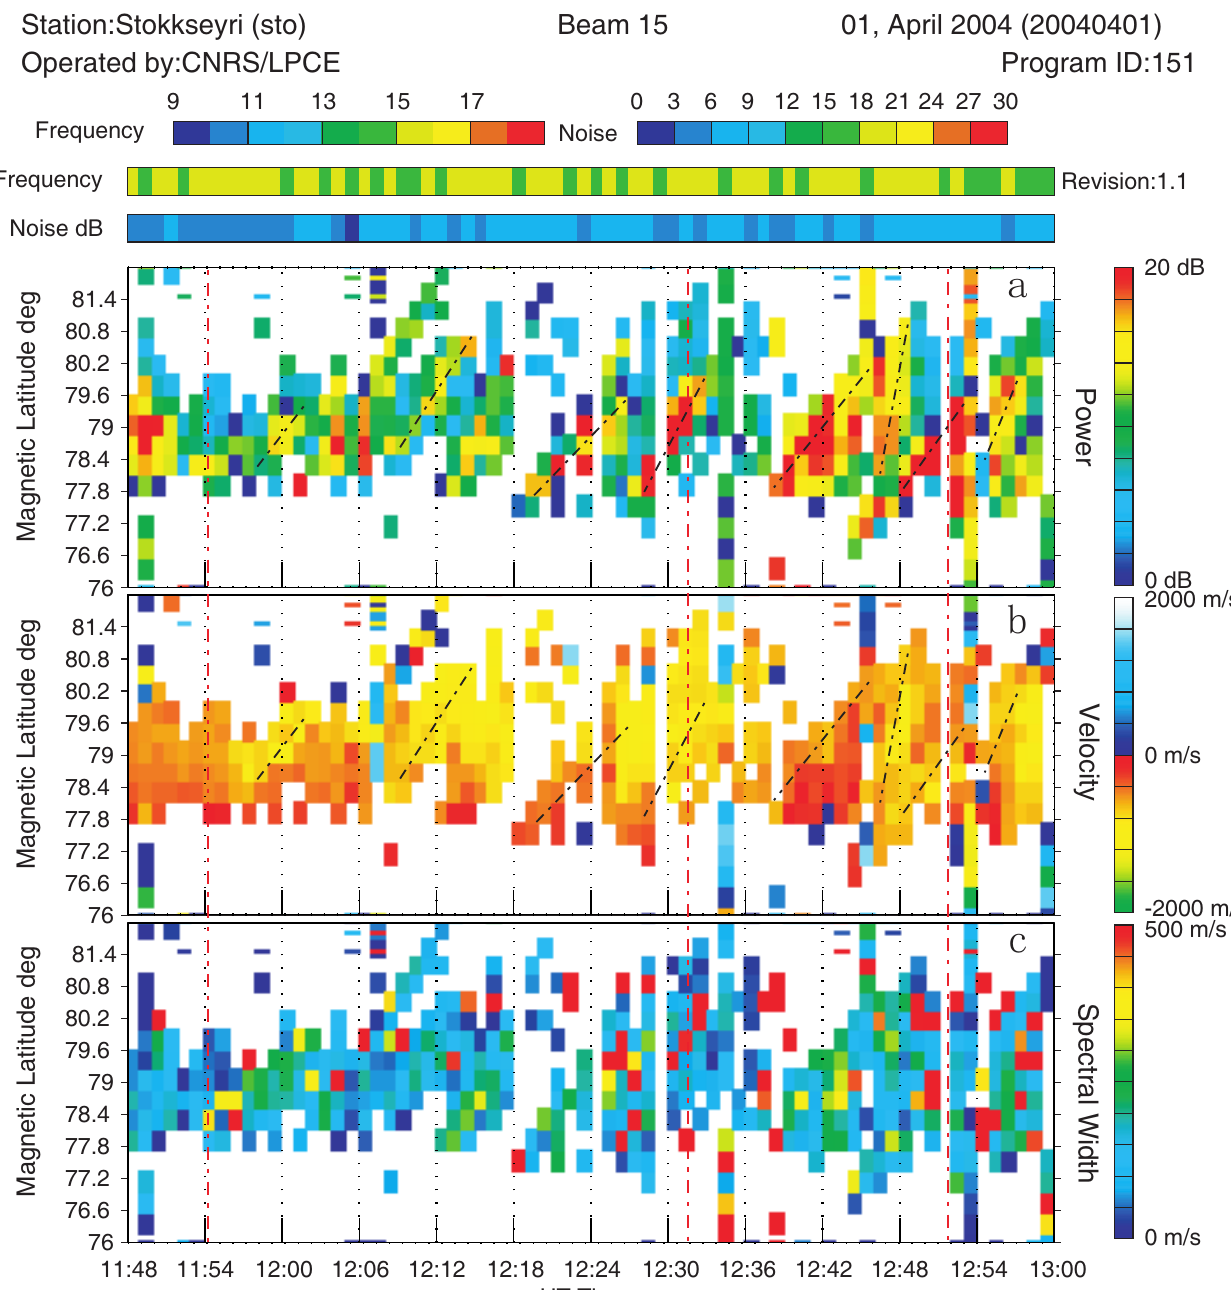
Fig. 5. Backscatter power (a) , l-o-s Doppler velocity (b) and Doppler spectral width (c) measured by the Stokkseyri SuperDARN radar during the period 11:48–13:00UT on 1 April